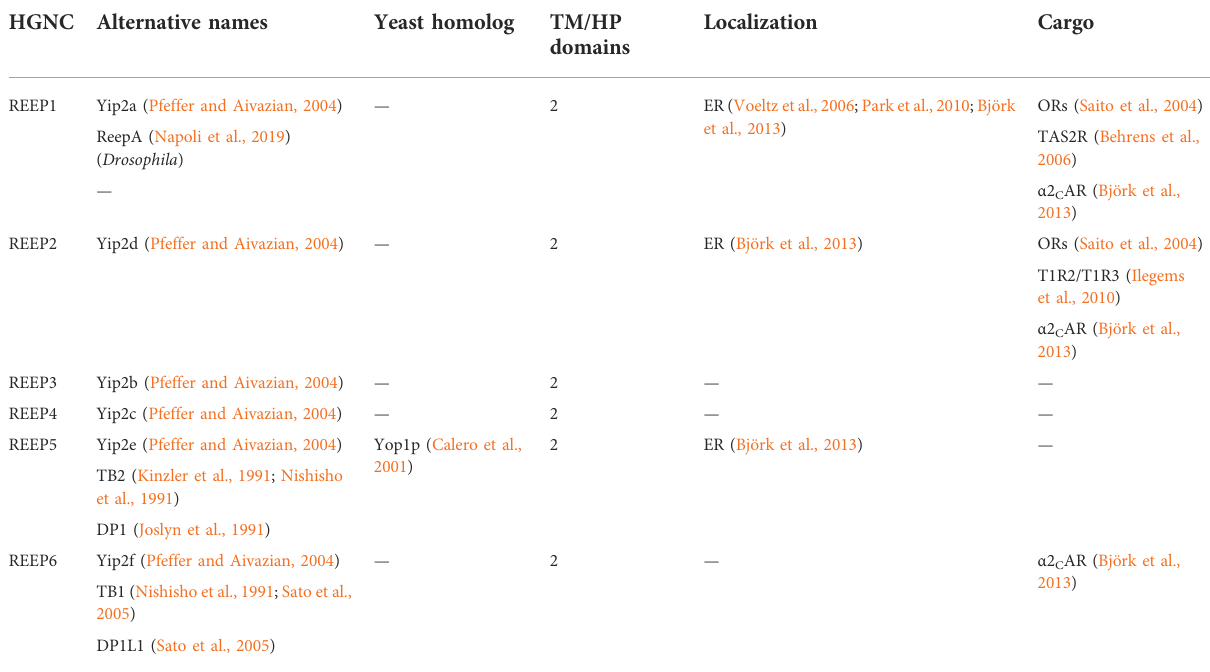
TABLE 3 Mammalian REEP/Yip2